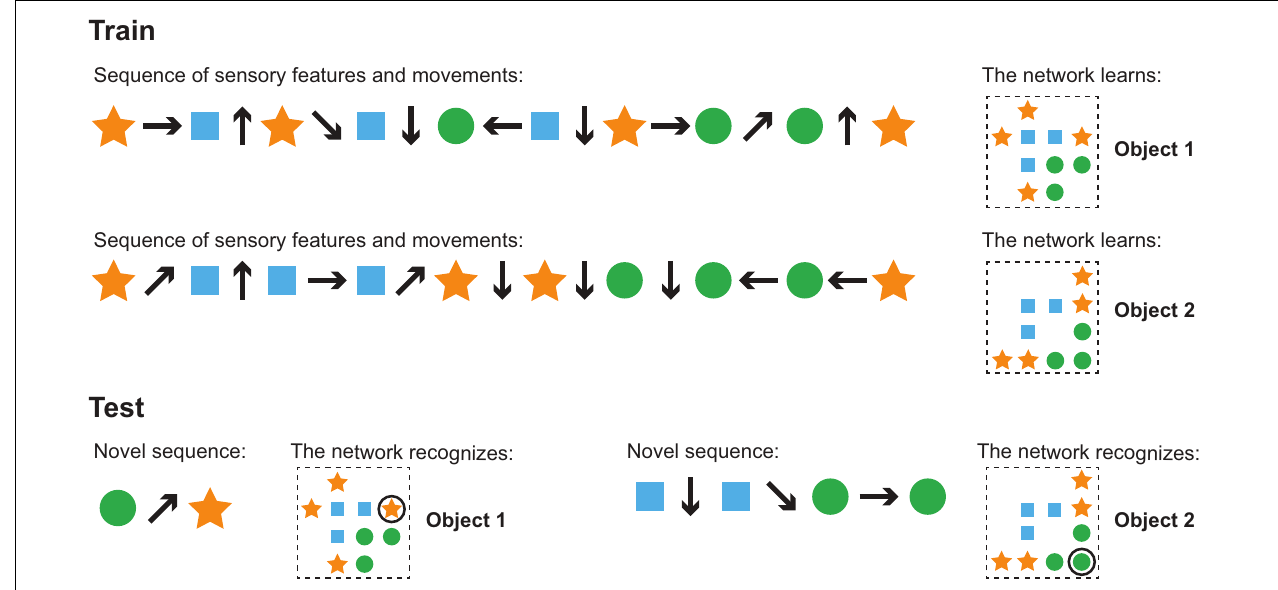
FIGURE 5 | Our model learns and recognizes objects from sensorimotor sequences. The order of movements and sensations is not critical for either learning or recognition. We ran simulations to test these properties. This cartoon figure illustrates a training and test run of one of these simulations. (Train) Two objects are shown (right side). Each object is composed of the same sensory features (circle, square, star) in different spatial arrangements. The network learns the objects via a sequence of sensory features and movements (left). Note that the model learns the relative arrangement of the features (right), not the sensorimotor sequence itself (left). (Test) The network can recognize objects with novel sensorimotor sequences. The left input sequence consists of a sensed circle, a diagonally upward movement, and a sensed star. Although the network has never experienced this particular sensorimotor sequence before, it detects that this sequence matches a portion of object 1 and does not match any other objects. In this example, one movement and two sensations is sufficient to recognize the object and the sensor’s current location on that object. The right sensorimotor sequence matches locations on both objects until the fourth sensory input, so it takes three movements and four sensations to recognize that this is object